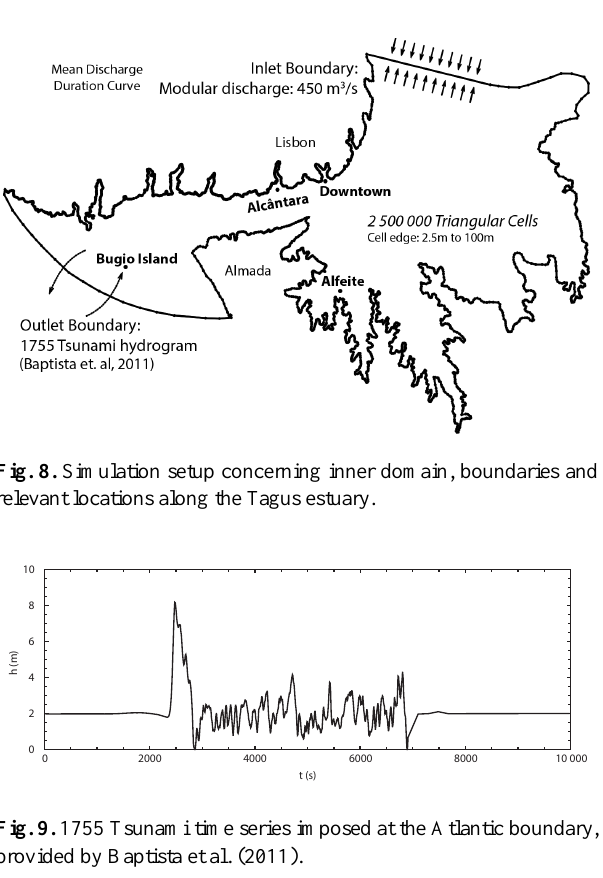
Fig. 9. 1755 Tsunami time series imposed at the Atlantic boundary, provided by Baptista et al. (2011).